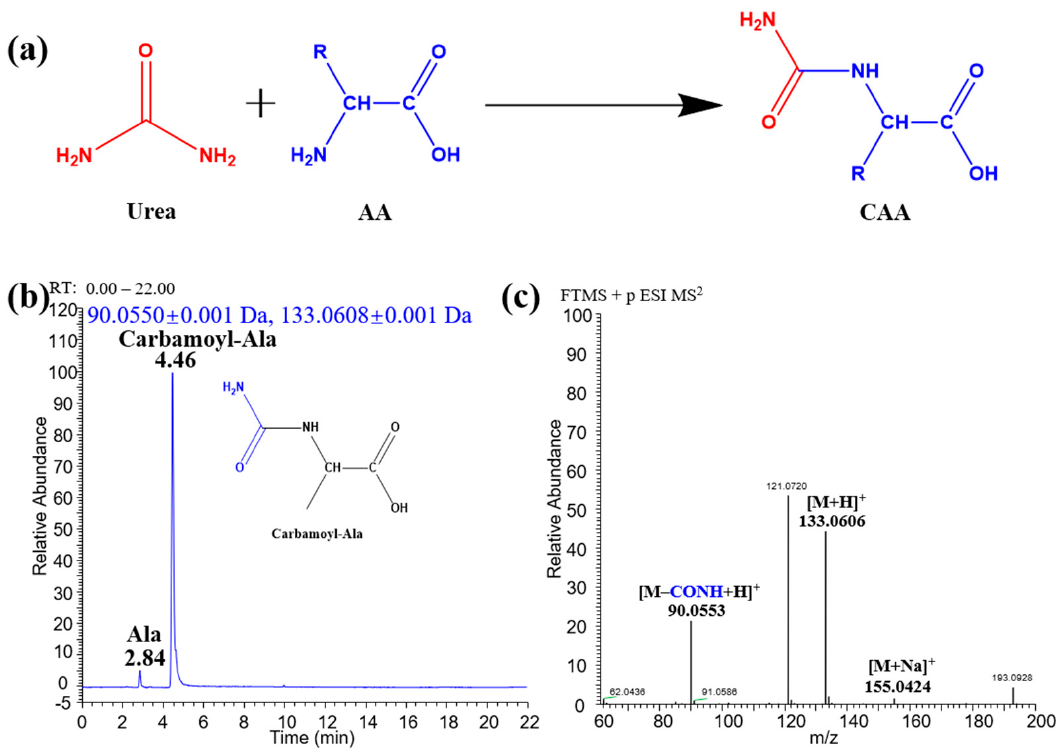
Figure 1. Urea derivatization reaction with AAs. ( a ) Reaction scheme. ( b ) EIC-MS profile of Ala and carbamoyl-Ala. ( c ) MS/MS spectrum of the product carbamoyl-Ala.